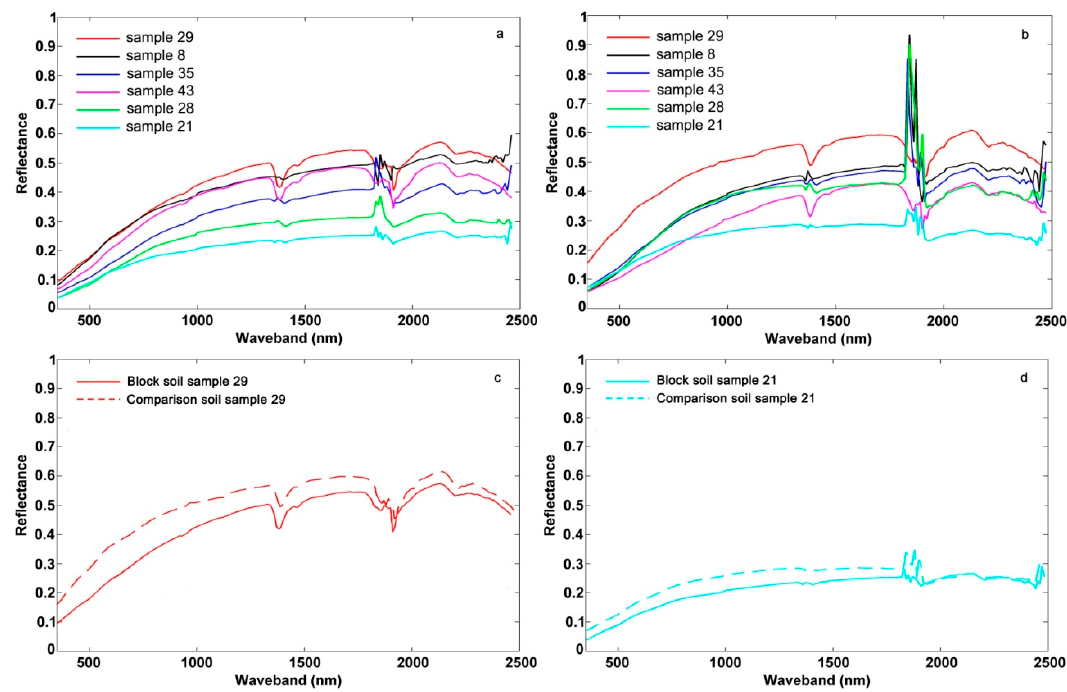
Figure 5. Reflectance of six selected soil samples. ( a ) Reflectance of block soil samples, ( b ) reflectance of comparison soil samples, ( c ) reflectance under block and comparison states of sample 29 with the lowest salinity, ( d ) reflectance under block and comparison states of sample 21 with the highest salinity.